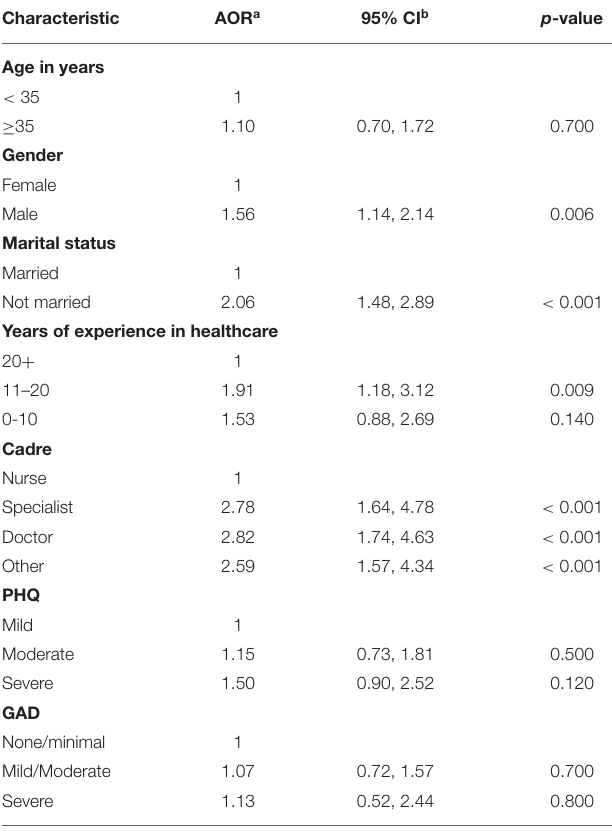
TABLE 5 | Multivariate analysis of association between harmful alcohol use and socio-demographic and mental health factors.